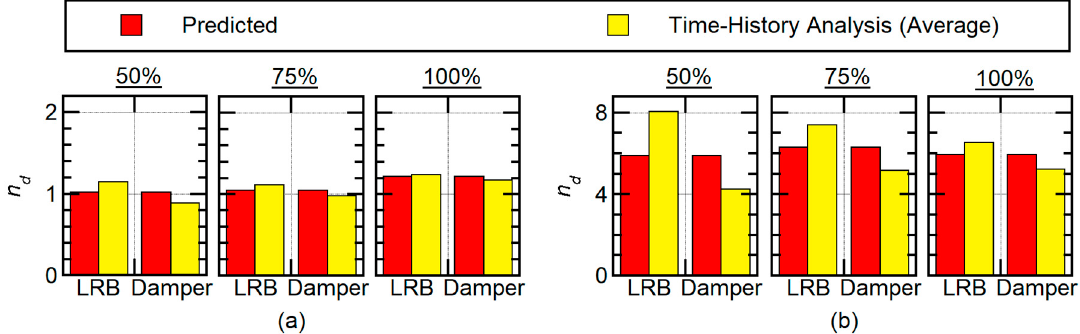
Figure 23. Comparisons between equivalent numbers of cycles for LRBs and dampers: ( a ) Art-S series; ( b ) Art-L series.